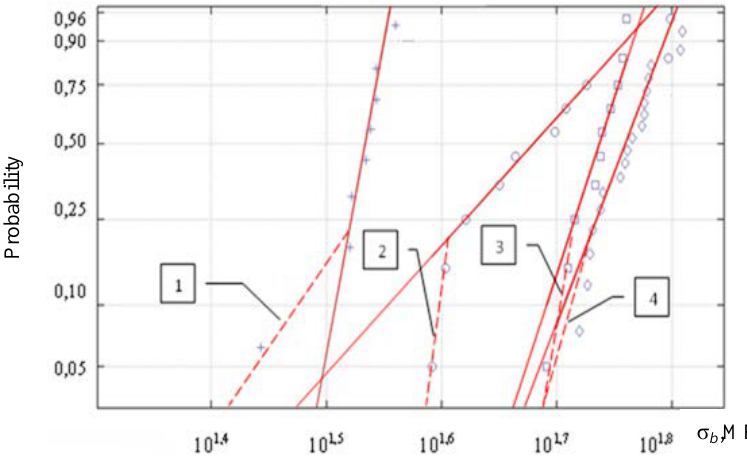
Fig.3 Weibull plots for ultimate bending strength σ b (solid lines – uni-modal distribution, dotted lines – lower branch of bi-modal distribution) for samples with length: 1 – 3.21 m, 2 1.21 m, 3 – 0.8m, 4 – 0.4m.